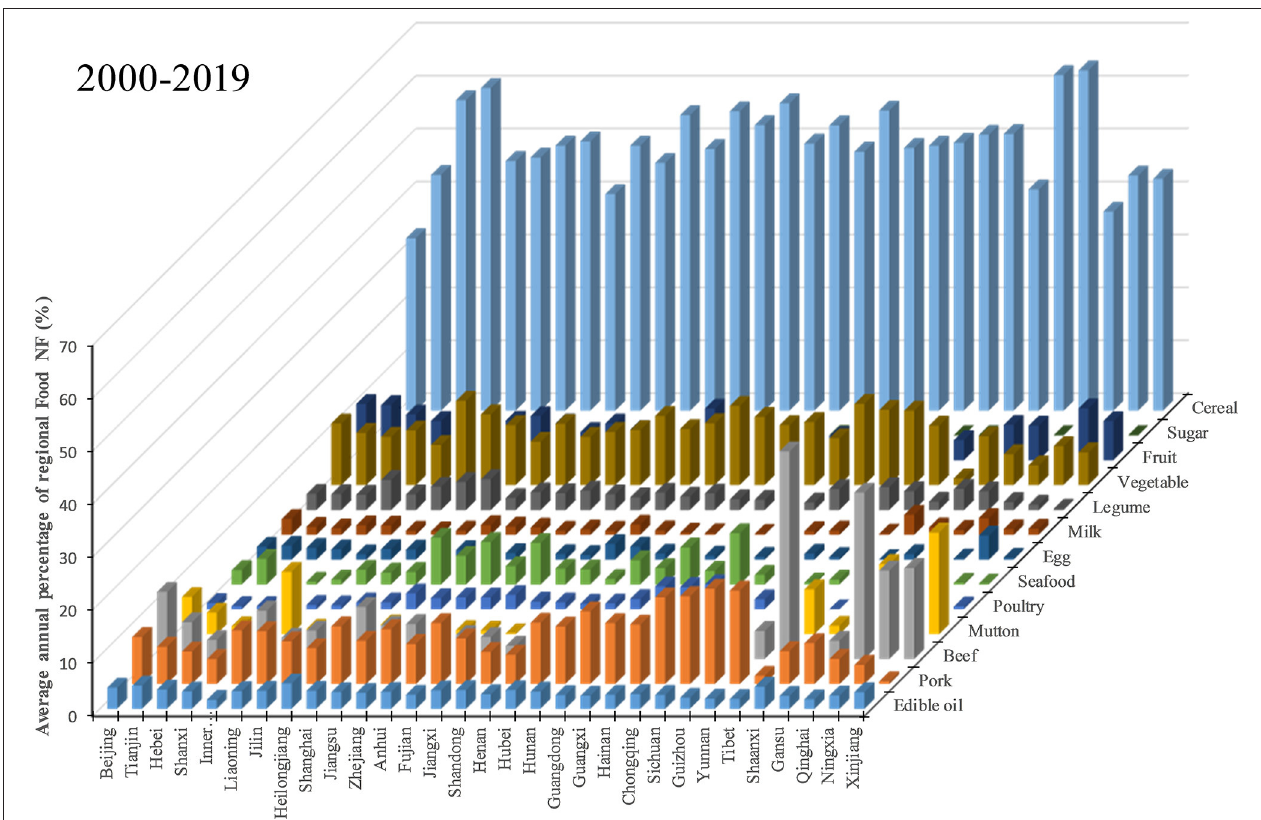
FIGURE 3 | Average annual percentage of regional food NFs attributed to various food types from 2000 to